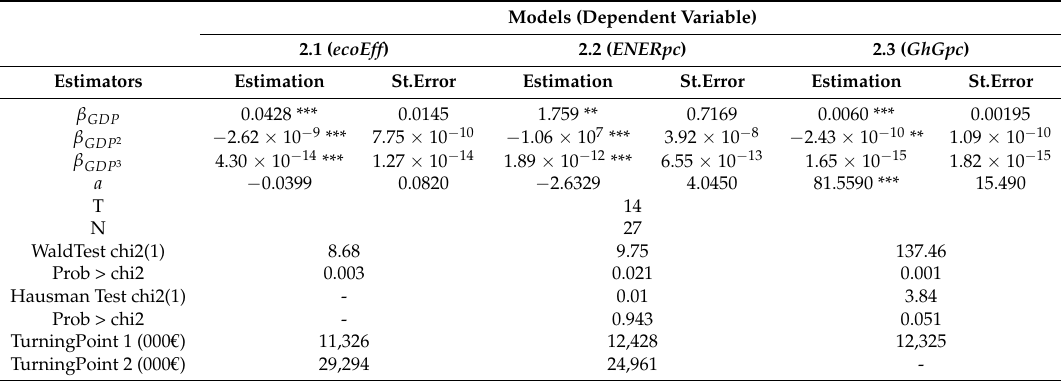
Table 3. Models 2.1, 2.2 and 2.3 estimation